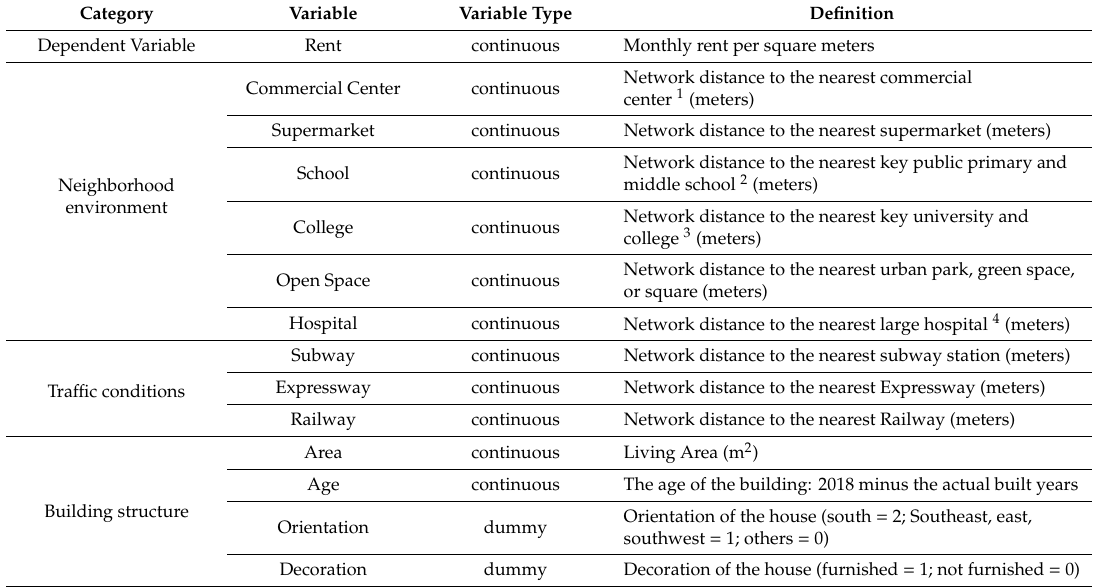
Table 1. Descriptions of the variables.